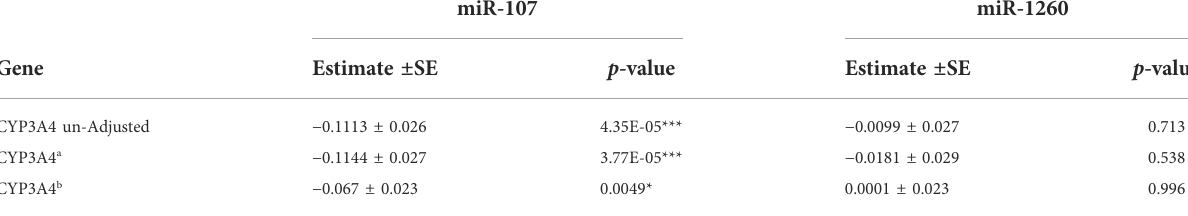
TABLE 2 Association between the expression levels of miR-107/miR-1260 and CYP3A4 protein levels in human liver samples ( n = 154) using linear regression analysis.